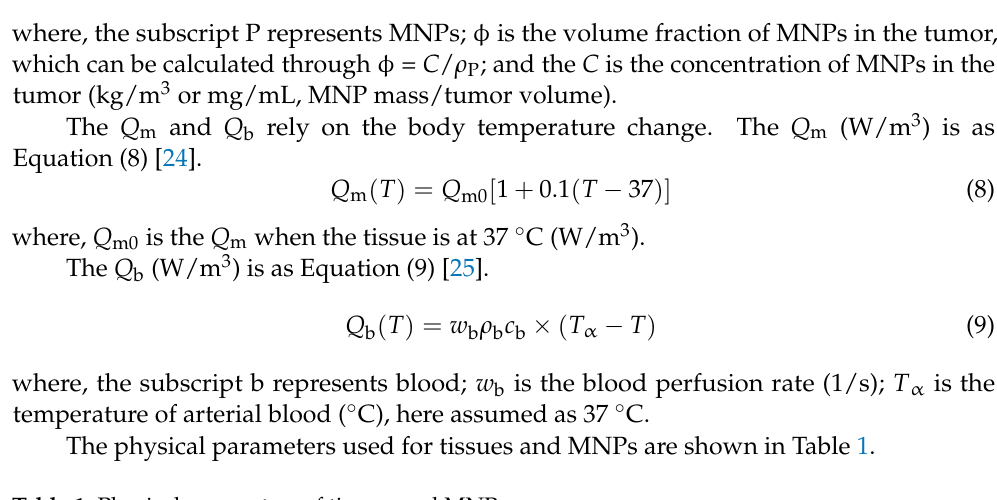
Table 1. Physical parameters of tissues and